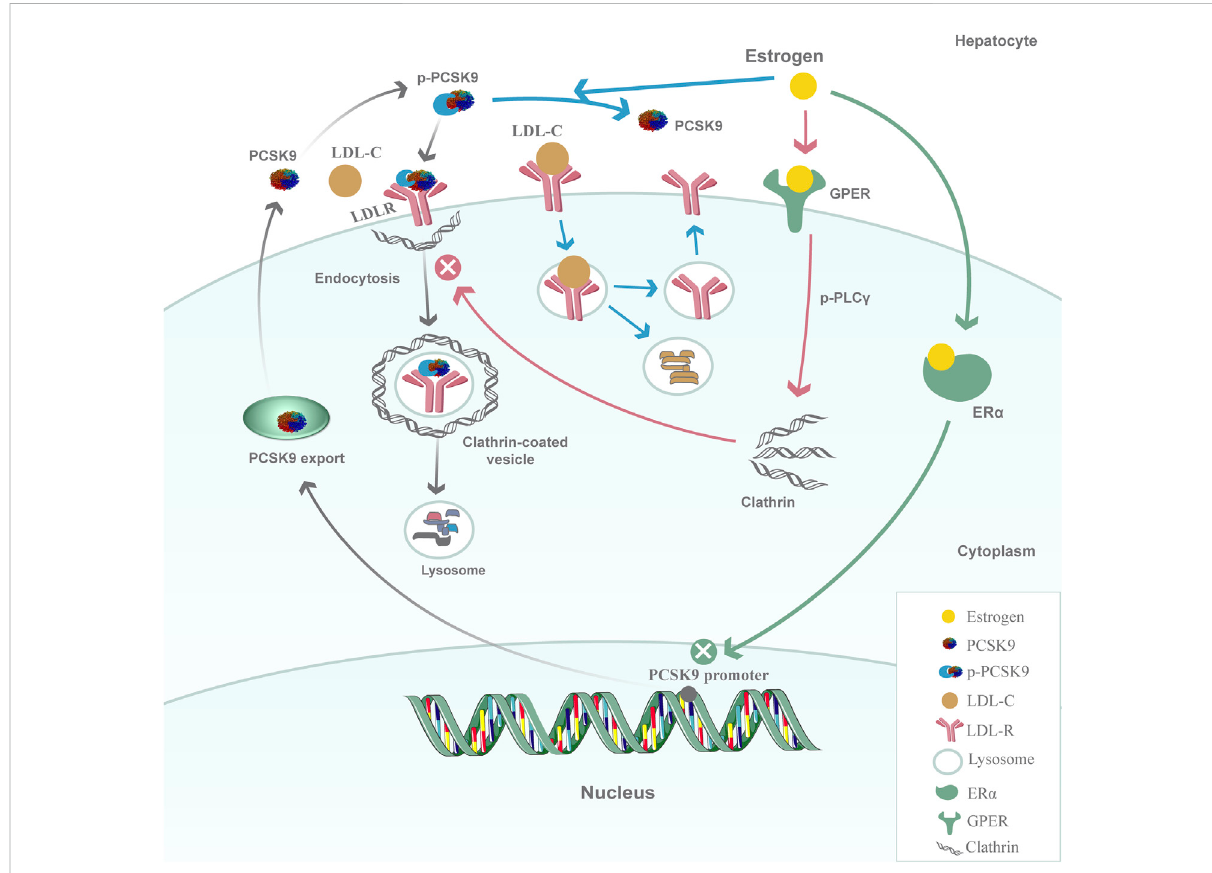
FIGURE 1 Model fortheregulationof PCSK9 byestrogen inhepatic cells. At thetranscriptional level, estrogeninhibits PCSK9 proximal promoter activities and decreases PCSK9 mRNA expression through the ER α -mediated pathway; at the posttranscriptional level, the activation of GPER in the membranebyestrogenrapidlyinitiatesthephosphorylationofPLC γ andthenaltersclathrindistributionorin fl uencestheclathrintraf fi ckingpathway to affect the internalization of the PCSK9-LDLR complex. Another possible mechanism is that estrogen could affect the PCSK9-LDLR interaction by inhibiting the phosphorylation of PCSK9 to protect LDLRs from